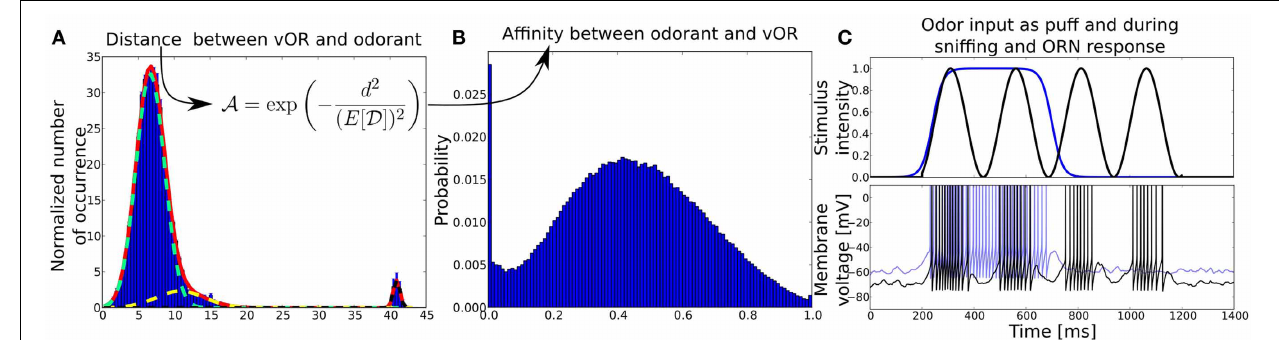
FIGURE 2 | (A) Distribution of distances D between virtual ORs and real-world odorants in a high-dimensional physico-chemical descriptor space taken from Haddad et al. (2008). Distances are obtained by clustering the multidimensional odor space a with k-means clustering algorithm, treating the resulting centroids as virtual ORs and averaging the Euclidean distances between ORs and odors over 100 trials. The red solid line shows the fit of a superposition of three normal distributions (light green, yellow, black dotted lines) to the mean distance distribution averaged over multiple clustering trials with number of ORs ranging from 20 to 66. Before the fitting, the distance distribution has been normalized